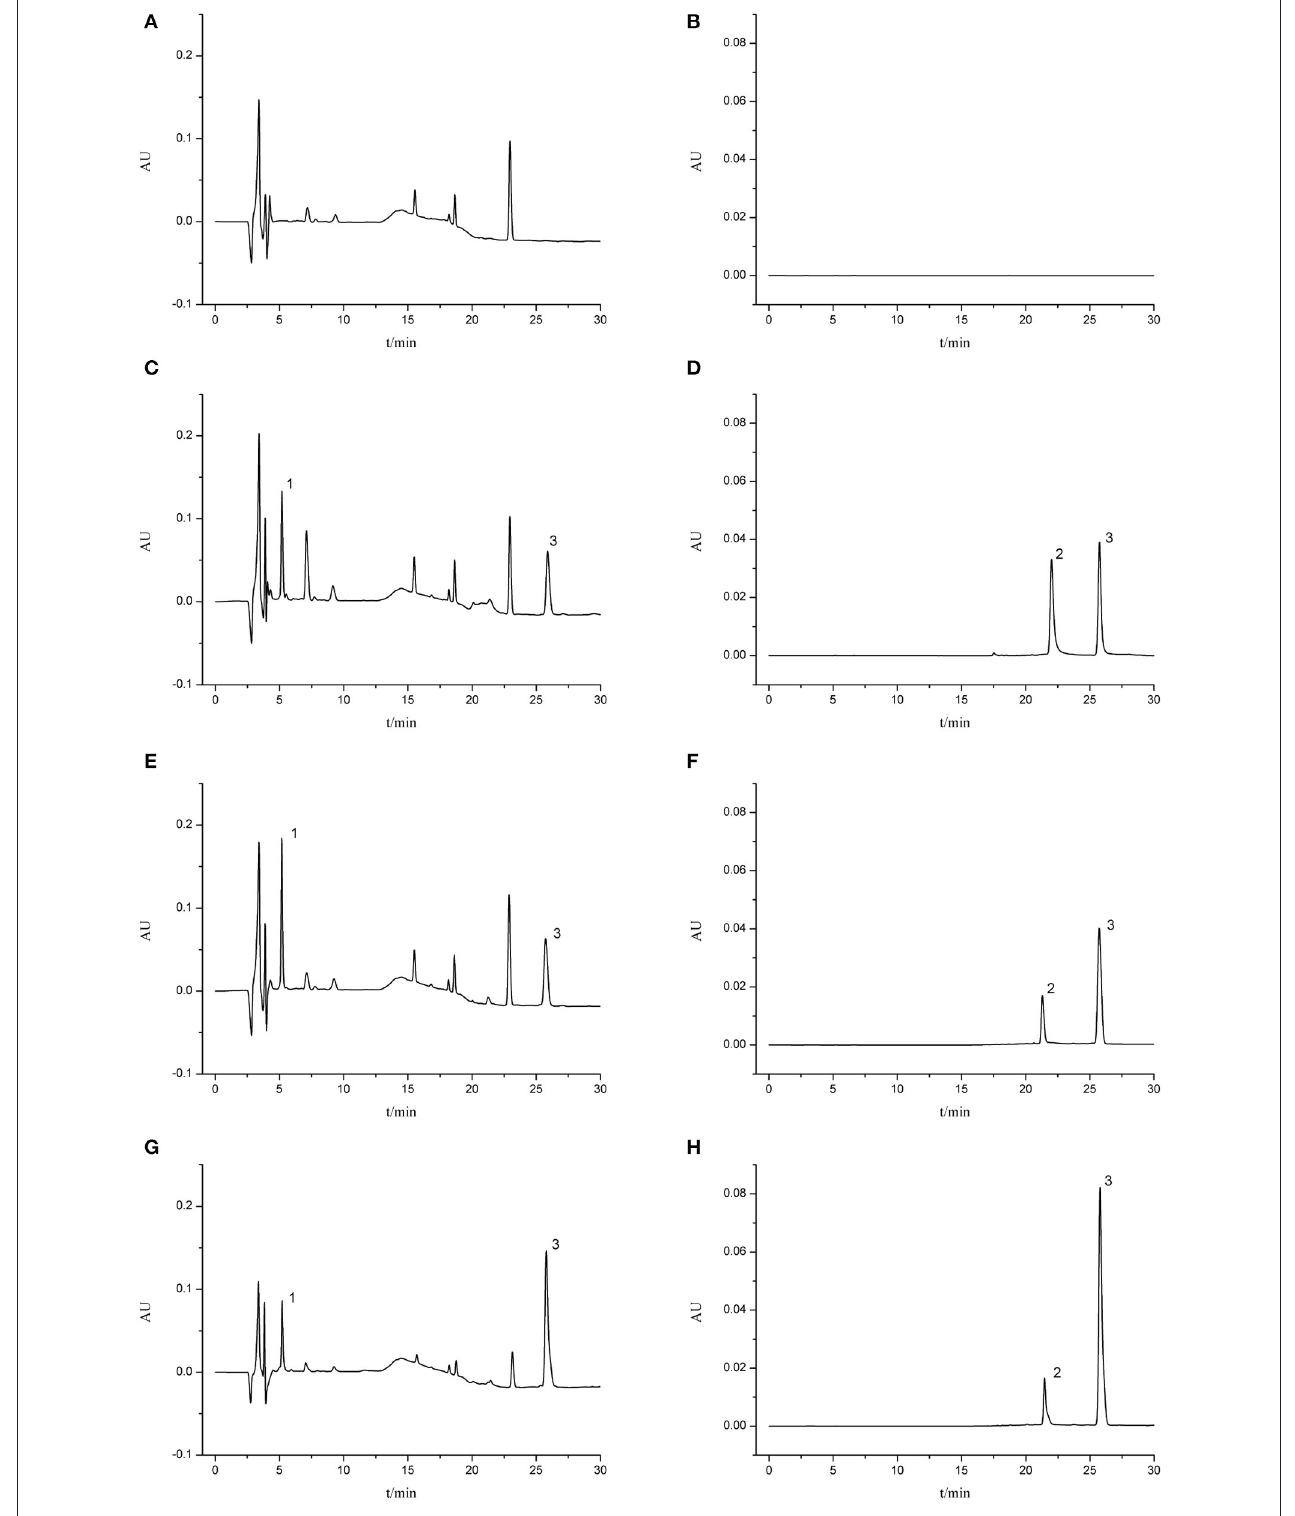
FIGURE 2 | Typical chromatograms of rat plasma. (A) Blank serum sample (210nm); (B) blank serum sample (403nm); (C) blank serum sample spiked with aceglutamide and riboflavin (210nm); (D) blank serum sample spiked with HSYA and riboflavin (403nm); (E) MCAO group 5min after GHI injection (210nm); (F) MCAO group 5min after GHI injection (403nm); (G) Normal group 5min after GHI injection (210nm); (H) Normal group 5min after GHI injection (403nm) (1: aceglutamide; 2: HSYA; 3: riboflavin).